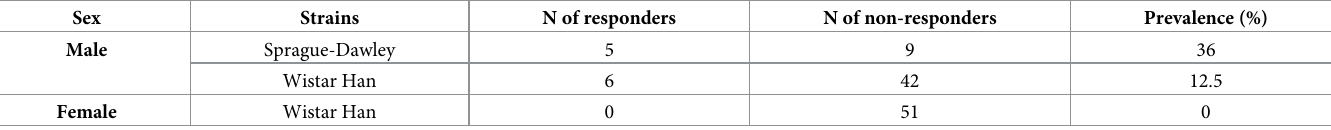
Table 1. Prevalence of hand-induced 22-kHz ultrasonic vocalizations in Sprague-Dawley and Wistar Han rats. Sex Strains N of responders N of non-responders Prevalence (%) Male Sprague-Dawley 5 Wistar Han Female Wistar